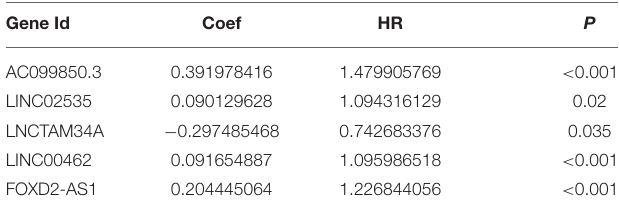
TABLE 1 | The 5 differently expressed long non-coding RNAs (lncRNAs) closely related with the overall survival (OS) of papillary renal cell carcinoma (pRCC) patients based on the multivariate Cox regression